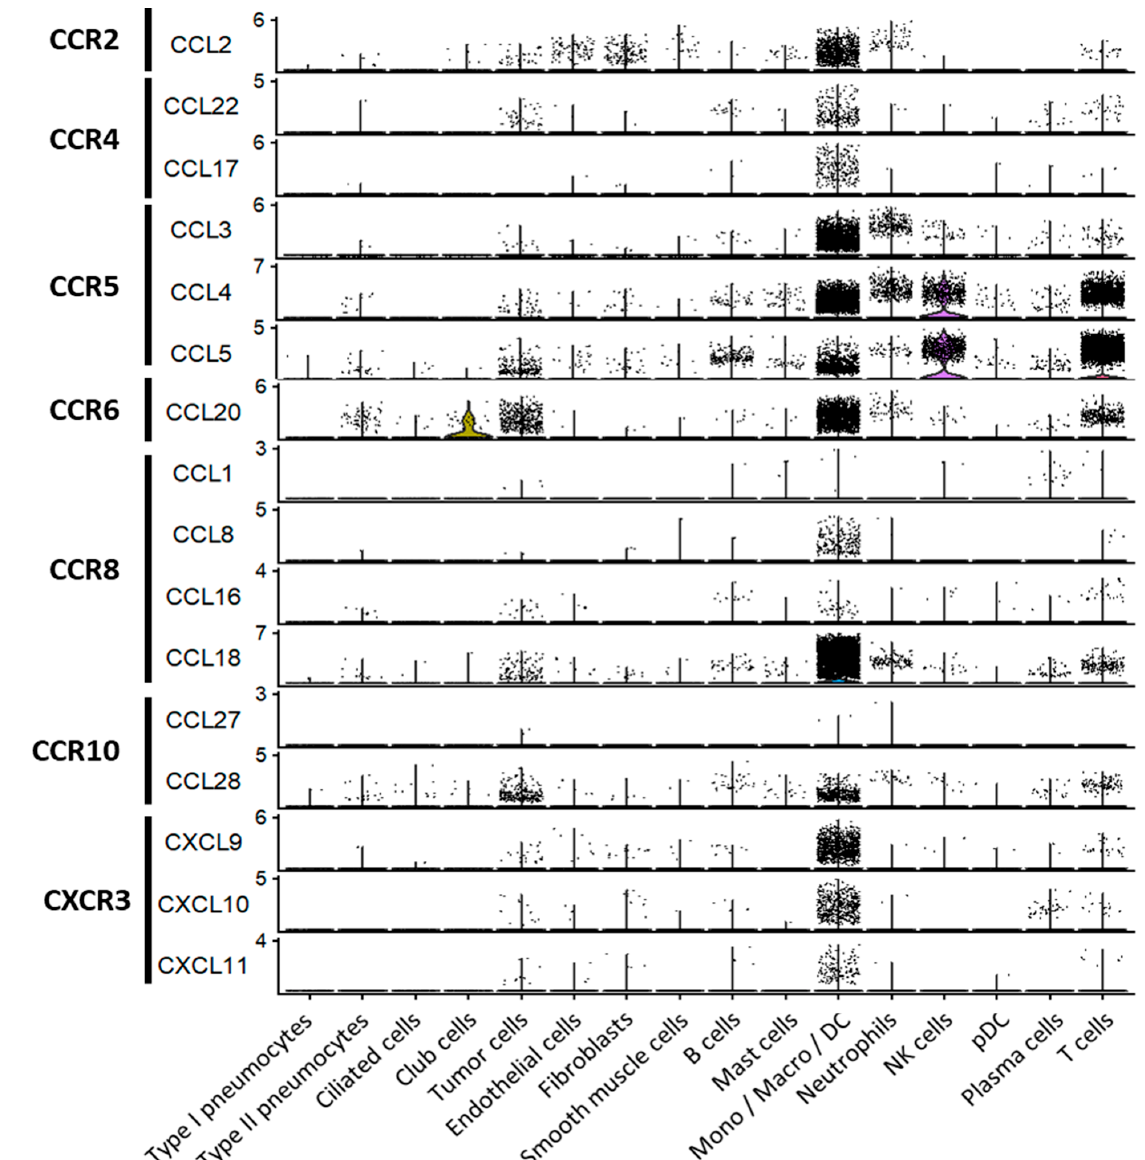
Figure 3. Characterization of cells (immune and nonimmune populations) expressing genes of chemokines in human NSCLC.